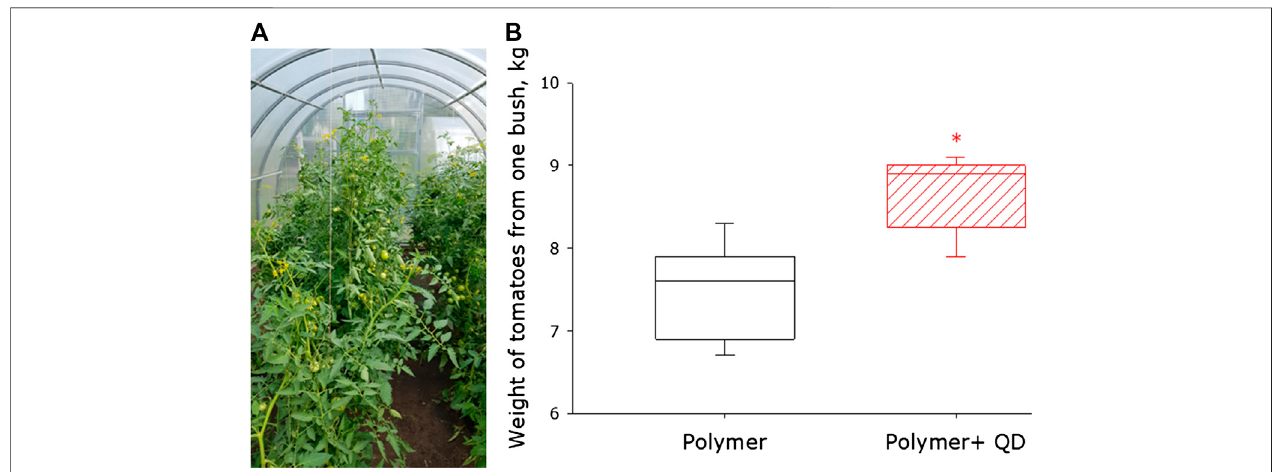
FIGURE 4 | In fl uence of photoconversion fl uoropolymer fi lm on tomato yield. (A) Photo of tomatoes grown inside a greenhouse made from photoconverted polymer fi lm. (B) Weight of tomato berry harvested from one tomato bush grown under a control polymer fi lm and photoconversion plastic fi lm. Data are presented as median with 95% con fi dence interval (box). The range is shown in the form of a whiskers. Statistically signi fi cant differences between control group and QD groups (Mann-Whitney U test, p < 0.05) are marked by asterisks.